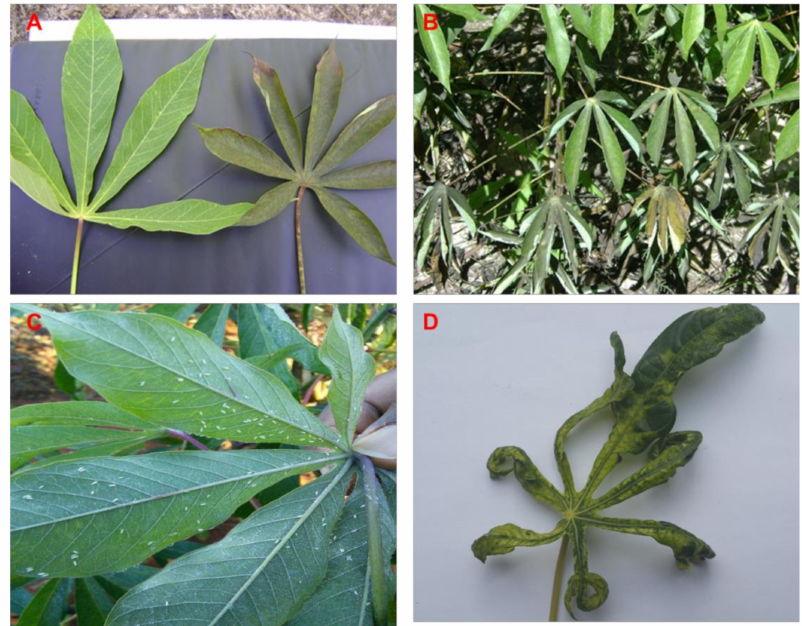
Figure 1. ( A ) Healthy leaf on the left and leaf with sooty mold on the right. ( B ) Cassava plant showing leaves with sooty mold. ( C ) Cassava leaves with Bemisia tabaci . ( D ) Cassava leaf showing severe symptoms of cassava mosaic